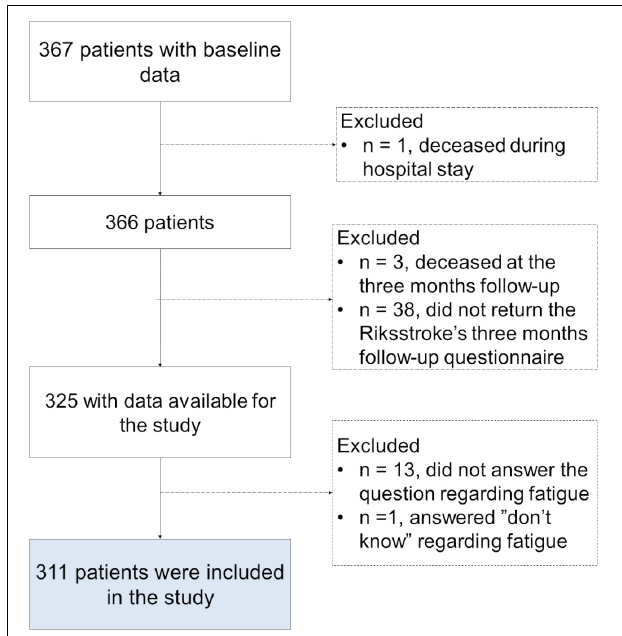
FIGURE 1 | Flowchart of study inclusion.